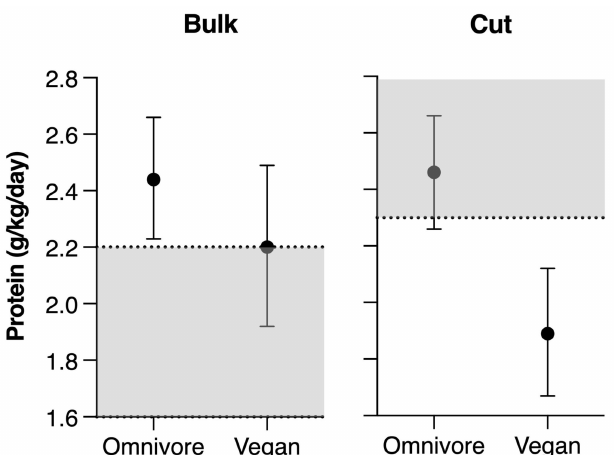
Figure 1. Protein intake of omnivore and vegan bodybuilders in relation to recommended values (grey area) for the two phases of the competitive